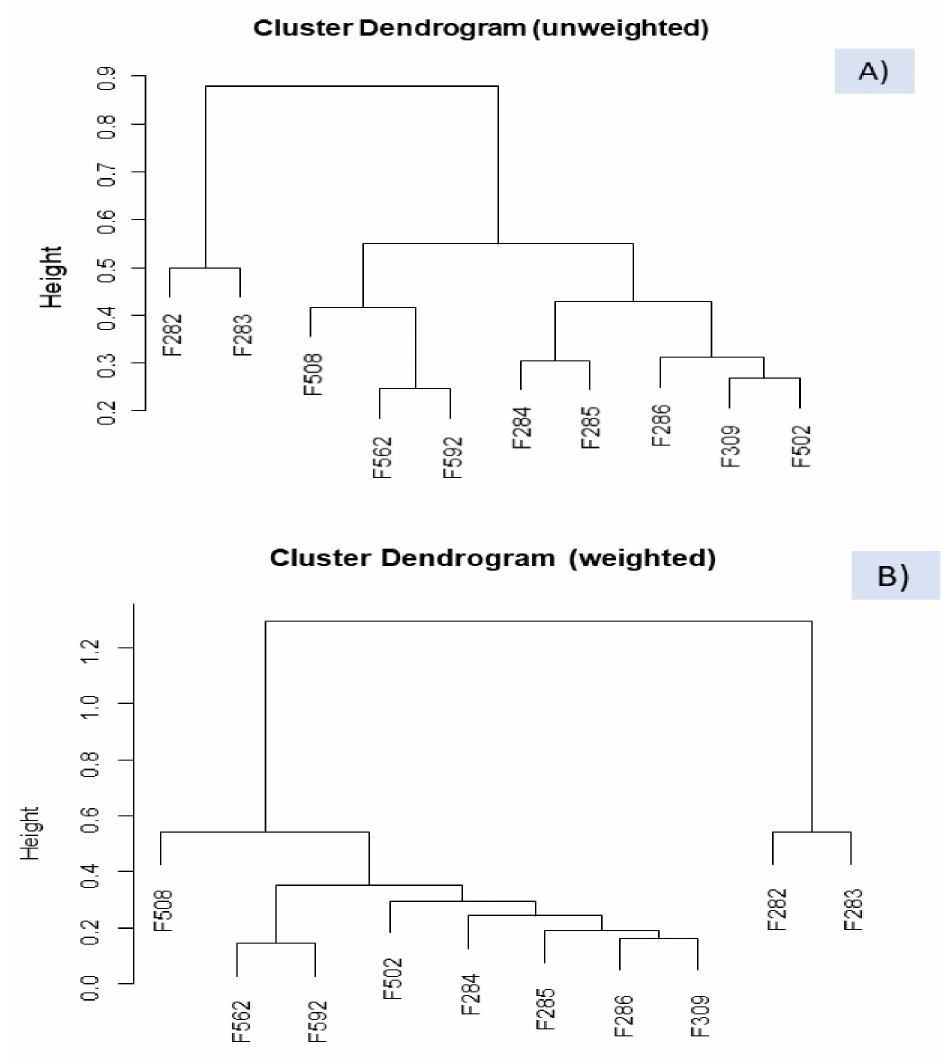
Figure 6. Clustering of samples, based on clr coefficients , using the WARD function from easy- CODA and the unweighted ( A ) and weighted ( B ) options. Symbols of samples correspond to industry A (F282 and F283, affected by butyric spoilage; F284, F285, F286, F309, normal fermen- tation) and industry B (F508 and F562, sulfidic and putrid spoilage, respectively; F502 and F592, normal